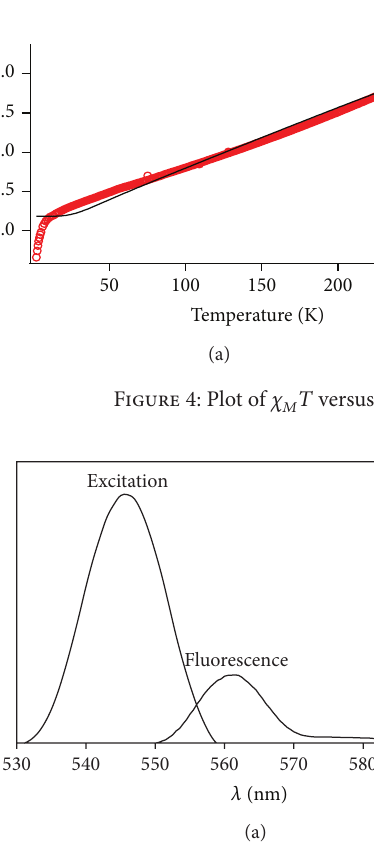
Figure 5: The excitation and fluorescence spectra of (a) 1 ( 𝜆